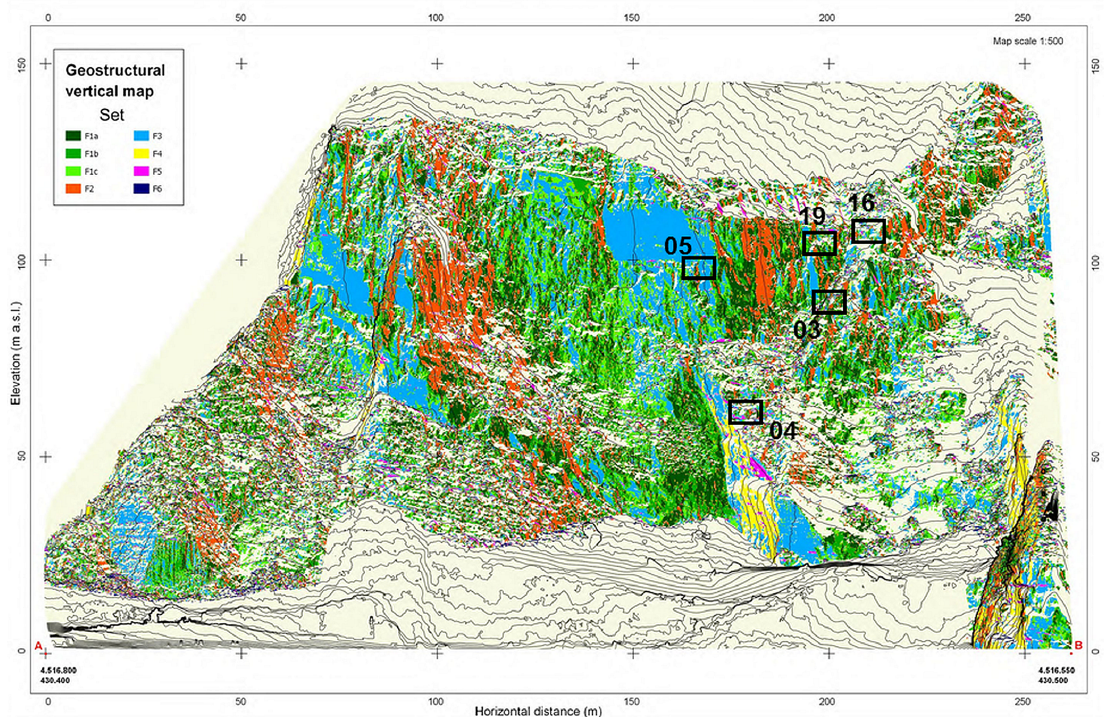
Figure 4. Geostructural vertical map (modified by Matano et al., 2016). Black boxes show location of the monitored unstable tuff blocks. Set legend (dip–dip direction): F1a ( > 65 ◦ /30–50 ◦ and 220–235 ◦ ), F1b ( > 65 ◦ /50–60 ◦ and 235–245 ◦ ), F1c ( > 65 ◦ /55–65 ◦ and 245–255 ◦ ), F2 ( > 65 ◦ /0–30 ◦ and 180–220 ◦ ), F3 ( > 70 ◦ /60–110 ◦ and 255–280 ◦ ), F4 ( > 70 ◦ /110–180 ◦ and 300–355 ◦ ), F5 (20–65 ◦ /50–195 ◦ ) and F6 ( < 20 ◦ /0–360 ◦ ). Table 1. Geostructural characteristics of the monitored tuff blocks. No. Size (width, length, Cliff local Joint sets ∗ Kinematic ID ID height; volume) orientation ∗ crackmeter tiltmeter 3 4.0, 2.0, 1.5m; 12.0m 3 85 ◦ /235 ◦ 82 ◦ /100 ◦ , 80 ◦ /5 ◦ , 85 ◦ /90 ◦ wedge sliding, toppling 03F1 – 4 1.5, 5.0, 1.0 m; 7.5 m 3 88 ◦ /255 ◦ 35 ◦ /240 ◦ , 85 ◦ /20 ◦ , 15 ◦ /290 ◦ planar sliding 04F1 04I1 5 2.0, 2.0, 1.5m; 6.0m 3 85 ◦ /275 ◦ 80 ◦ /100 ◦ , 75 ◦ /20 ◦ , 75 ◦ /230 ◦ wedge sliding, toppling 05F1, 05F2, 05F3 16 2.0, 2.0, 1.0m; 4.0m 3 80 ◦ /330 ◦ 70 ◦ /5 ◦ , 80 ◦ /350 ◦ , 78 ◦ /205 ◦ wedge sliding 16F1, 16F2 19 5.0, 2.0, 1.5m; 15.0m 3 87 ◦ /250 ◦ 88 ◦ /60 ◦ , 85 ◦ /240 ◦ , 48 ◦ /5 ◦ toppling 19F1, 19F2 19I1 ∗ Orientation is expressed with dip and dip direction values in the format “dip/dip